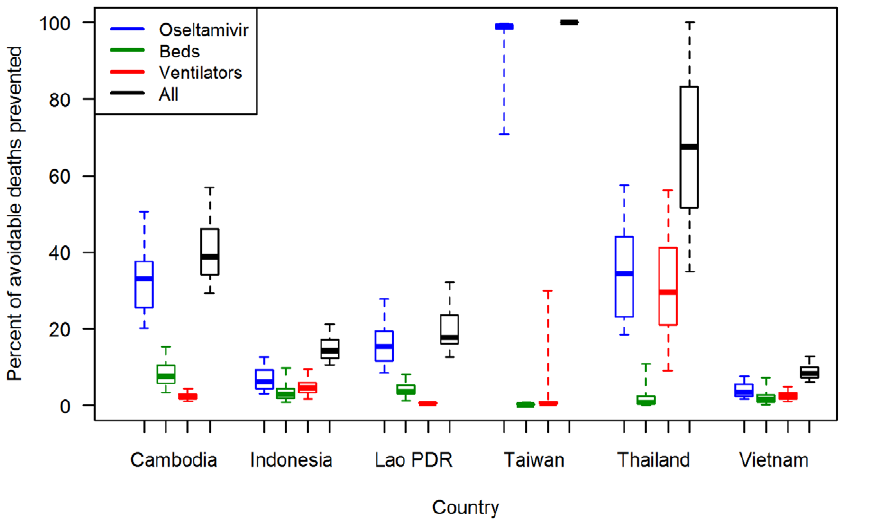
Figure 5. Estimated impact of resource mobilization/redistribution across provinces on avoidable mortality rates within each territory. Data were calculated by estimating the number of avoidable deaths if available resources (including central stockpiles for oseltamivir) within each territory were geographically distributed in proportion to provincial population size, and comparing with the total number of avoidable deaths predicted given actual resource distribution. Boxplots show medians, interquartile ranges, and 95 th percentile ranges derived from a multivariate uncertainty analysis. Data are aggregated across provinces for Cambodia, Lao PDR, Thailand, Vietnam, and across counties for Taiwan. Data for Indonesia are aggregated across districts of Jakarta and Bali only.